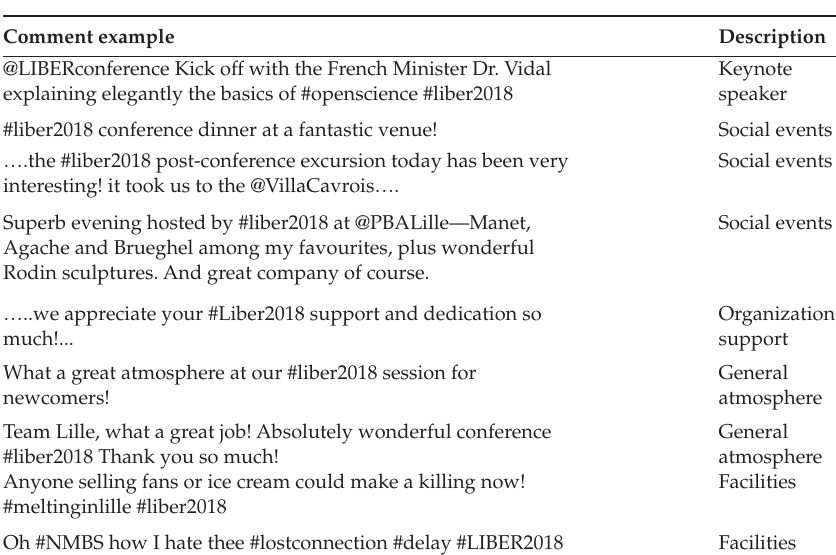
Table 4. Organisational